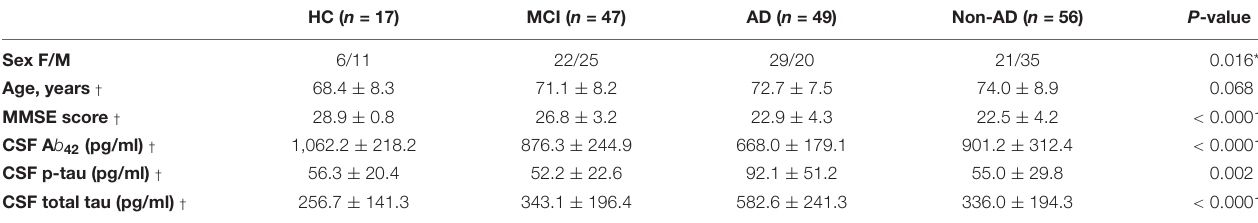
TABLE 1 | Characteristics of the study cohort.